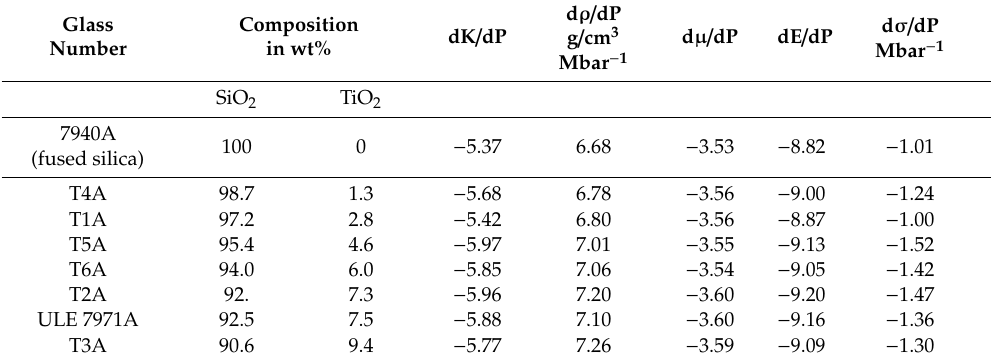
Table 2. Pressure derivatives of the elastic parameters (moduli in Mbar) of the annealed SiO 2 –TiO 2 glasses at ambient conditions.